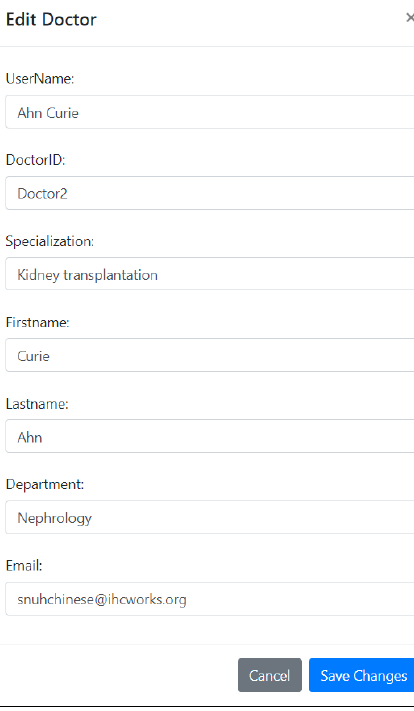
Figure 16. Update doctor